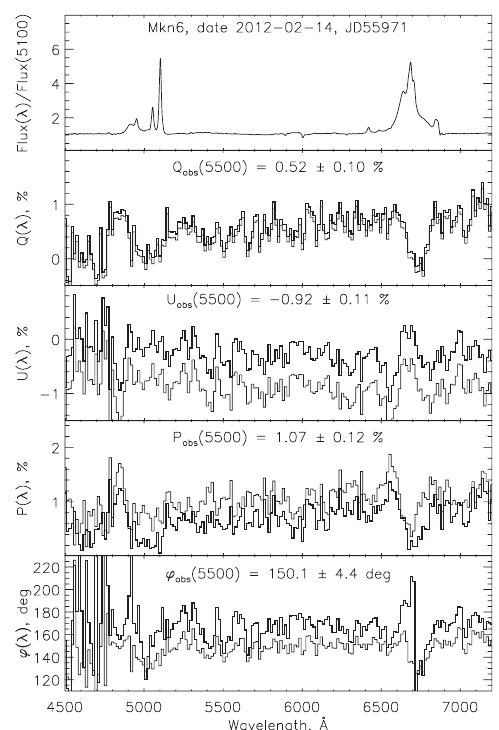
Figure 2. The spectrum and its polarization parameters observed on 2012 Feb 14. From top to bottom: the observed spectrum of Mrk 6, parameters Q and U and corresponding degree P and angle φ of polarization. The thin lines represent observed and the thick lines represent corrected spectra for the ISM polarization. The figure is taken from Afanasiev et al.